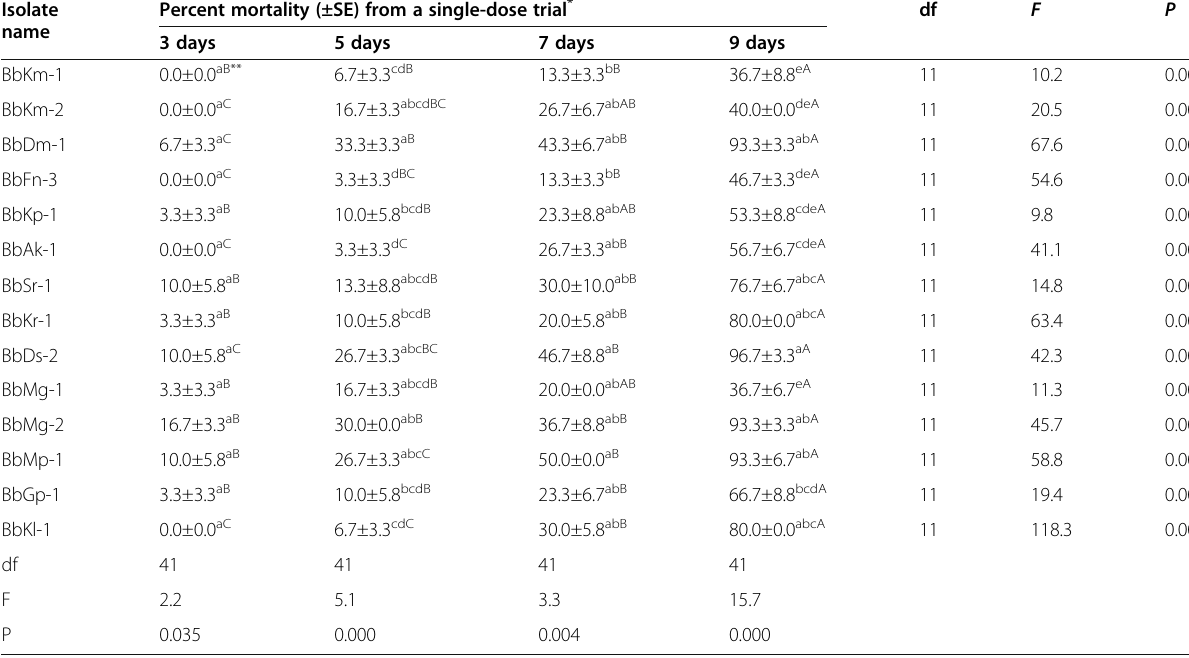
Table 5 Percentage mortalities of 0 – 48-h-old adults of Leptinotarsa decemlineata in response to the tested Beauveria bassiana isolates at 3, 5, 7, and 9 days after treatment under laboratory